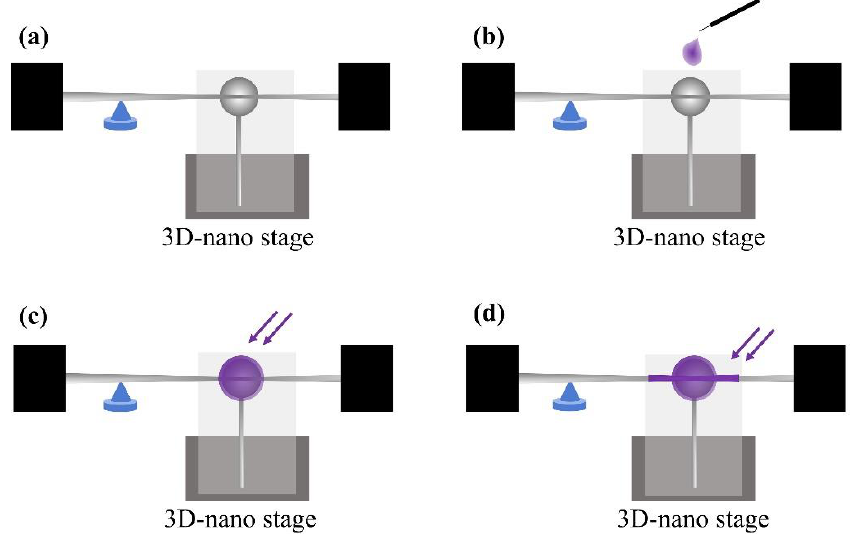
Figure 4. ( a – d ) Schematic diagram of the packaging process. The purple parts indicate the UV epoxy. Note that we could calibrate the WGM in the epoxy before it cured because its viscosity was small.